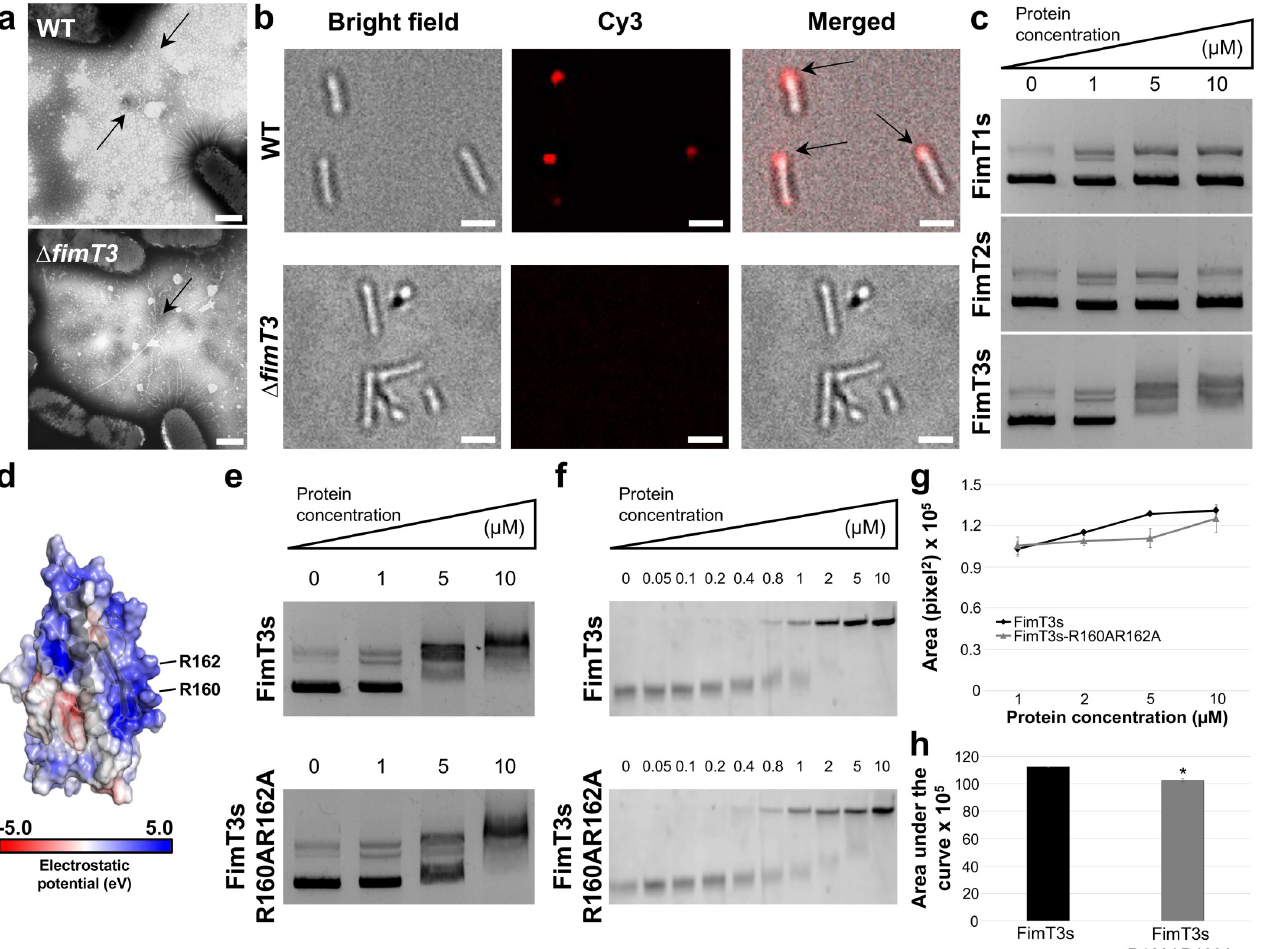
Fig 3. FimT3 DNA binding activity. a Transmission electron microscopy micrographs of pilus formation by X . fastidiosa WT and Δ fimT3 cells. Arrows are pointing to TFP. Similar events were captured in two independent experiments. Images were captured at 31,500 × magnification. Scale bars, 500 nm. b Uptake of Cy-3-labeled pAX1-Cm plasmid into a DNase I resistant state by X . fastidiosa cells observed using a fluorescence microscope. The images correspond to the bright field (left), Cy-3 channel (center) and merged images (right). In merged images, arrows are pointing to fluorescent DNA foci at the cell poles. Similar events were captured in three independent experiments. Images were captured at 100 × magnification. Scale bars, 1.5 μ m. c DNA-binding ability of purified FimT1s, FimT2s and FimT3s assessed by agarose EMSA. Similar events were captured in three independent experiments. d Surface electrostatics representation of FimT3 merged with its ribbon representation. The arginine amino acid residues (R160 and R162) that were mutated for functional studies are highlighted in the figure. The electrostatic potential (eV) color scale is shown in the figure. e DNA-binding ability of purified FimT3s and FimT3s- R160AR162A assessed by agarose EMSA. Similar events were captured in three independent experiments. f Titration of the DNA binding activity of FimT3s and FimT3s-R160AR162A by native acrylamide EMSA. Similar events were captured in two independent experiments. g Densitometry analysis of the DNA binding activity of FimT3s and FimT3s-R160AR162A in acrylamide EMSA. The fluorescent intensity of the shifted DNA bands of Cy-3-labeled Km resistance cassette presented in f was measured using ImageJ. The fluorescent intensity of shifted bands when treated only with 1, 2, 5, and 10 μ M of each protein was measured, since they presented higher shifts in electrophoretic mobility within this protein concentration range. h Area under the fluorescence curve. The area under the fluorescence curves in g was calculated to quantify the DNA-binding affinity of FimT3s and FimT3s-R160AR162A. Statistical significance was determined using Student’s t -test ( � indicates P < 0.05 in comparison to the wild-type protein; n = two independent replicates). Multiple bands of the pAX1-Cm plasmid observed in c and e are due to the multiple forms of the plasmid after purification, with each form displaying different sizes in agarose gels. the only gene essential exclusively for natural competence, the ability of FimT3 to bind to DNA and the loss of DNA acquisition from the extracellular environment by cells upon its deletion, demonstrate that this minor pilin is the DNA receptor of the X . fastidiosa TFP. To further characterize FimT3, we searched for specific amino acid residues involved in DNA-binding. The binding of DNA to TFP via a minor pilin was demonstrated in ComP of